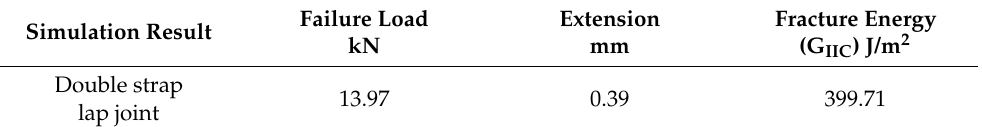
Table 7. Simulation result of tensile test.